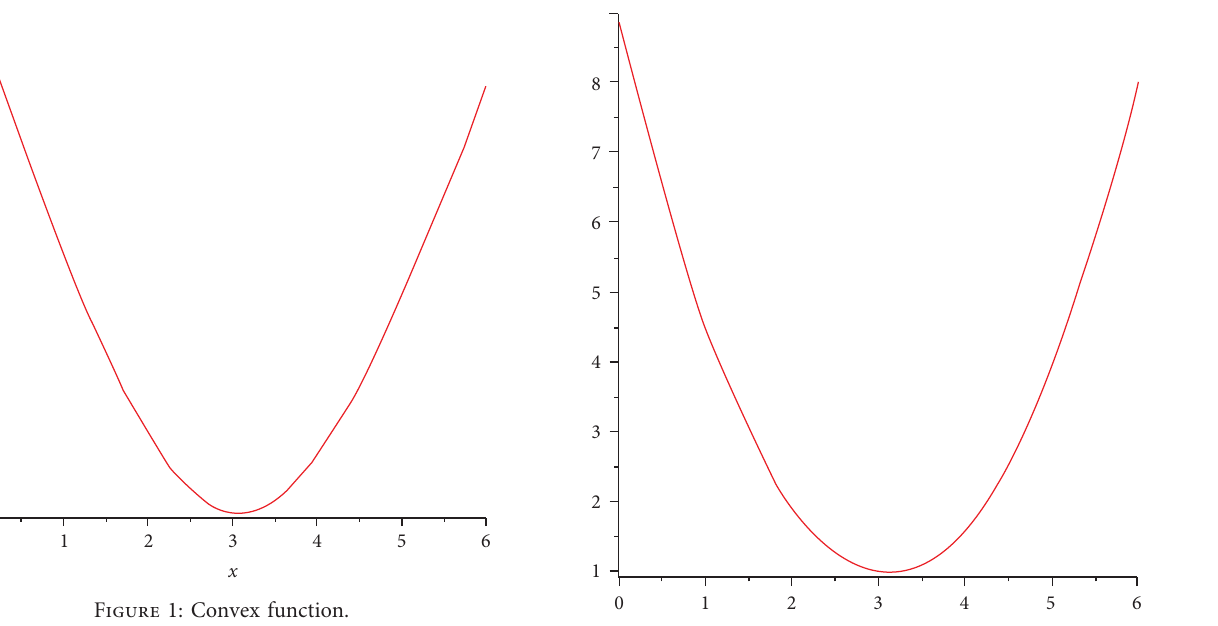
Figure 3: C 2 KNR biquadratic fractional spline curve.